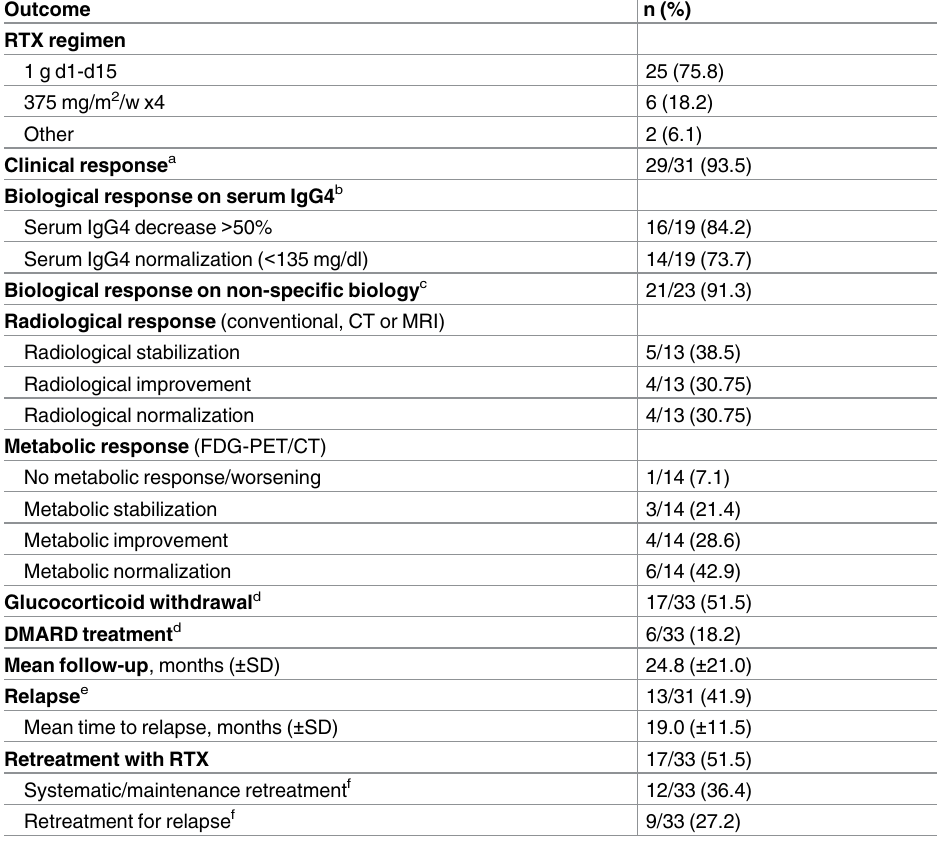
Table 3. Clinical, biological and radiological efficacyof RTX in 33 patients with